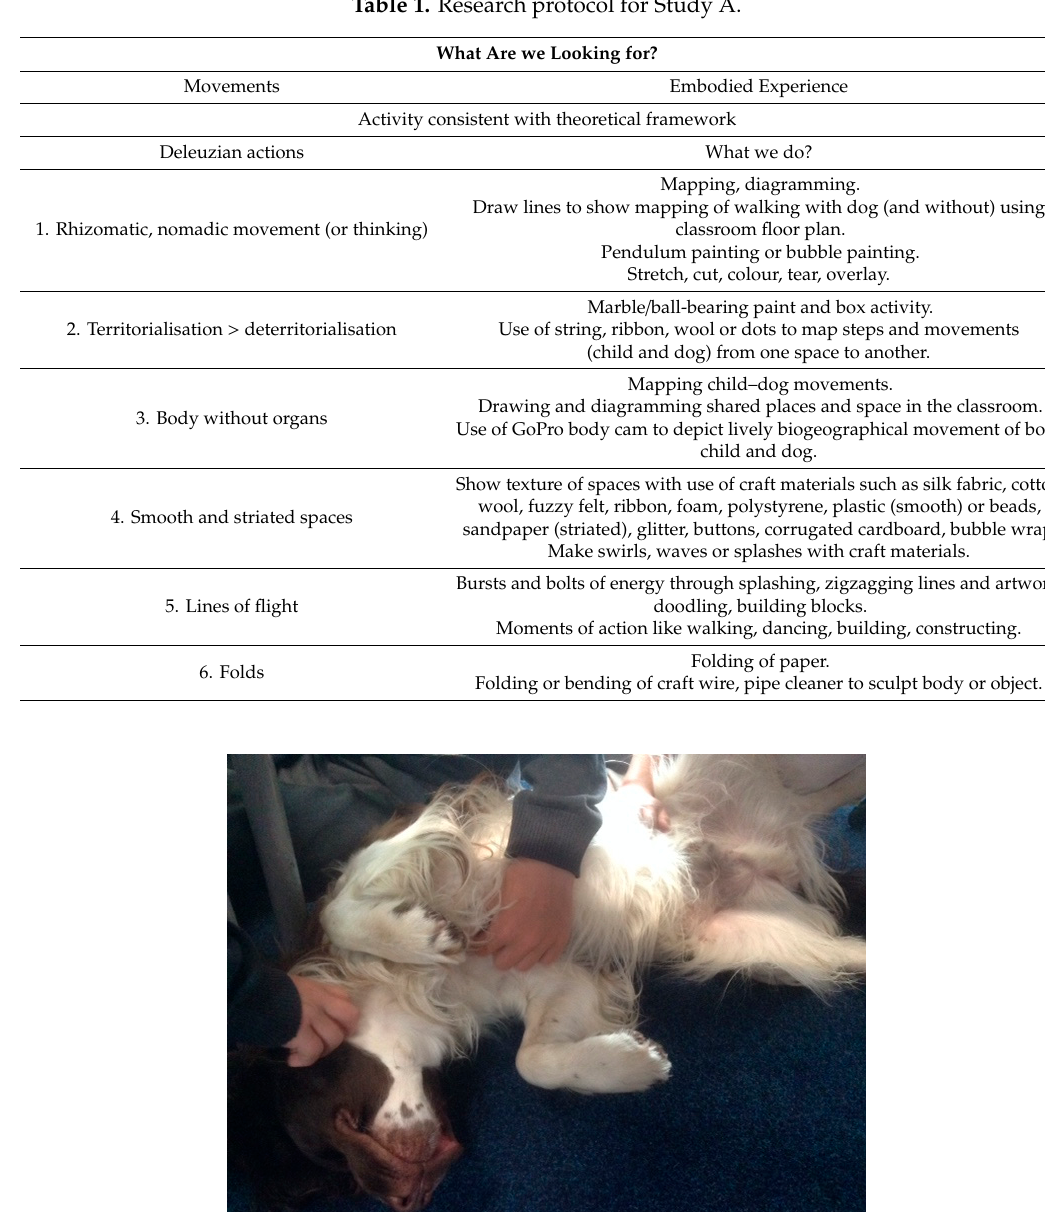
Table 1. Research protocol for Study A.